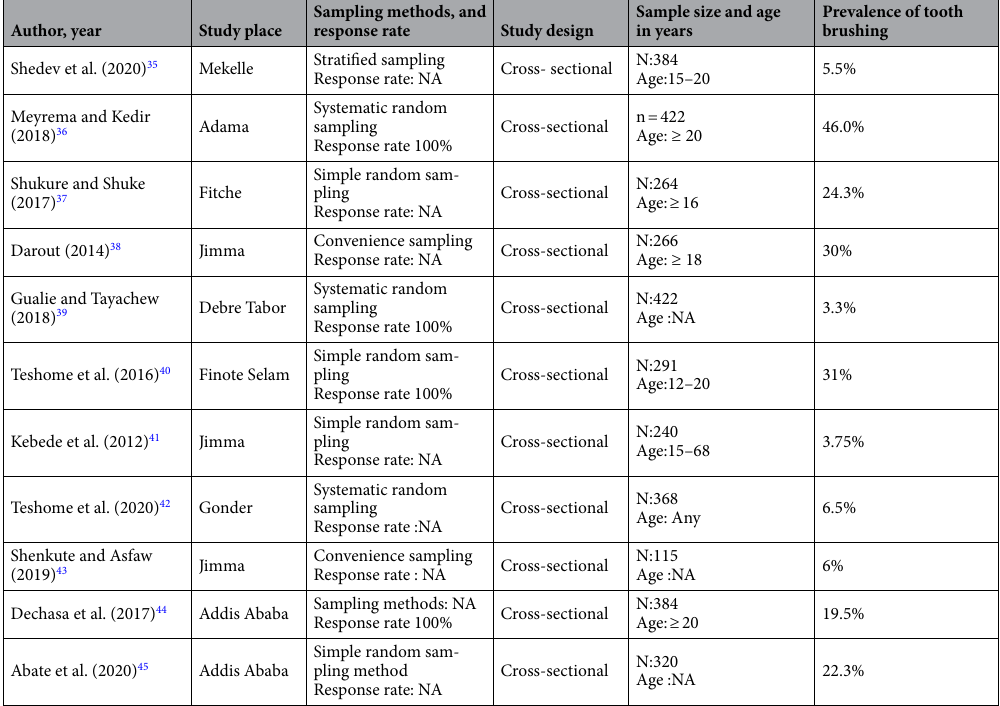
Table 1. Characteristics of included studies, their sampling methods, and